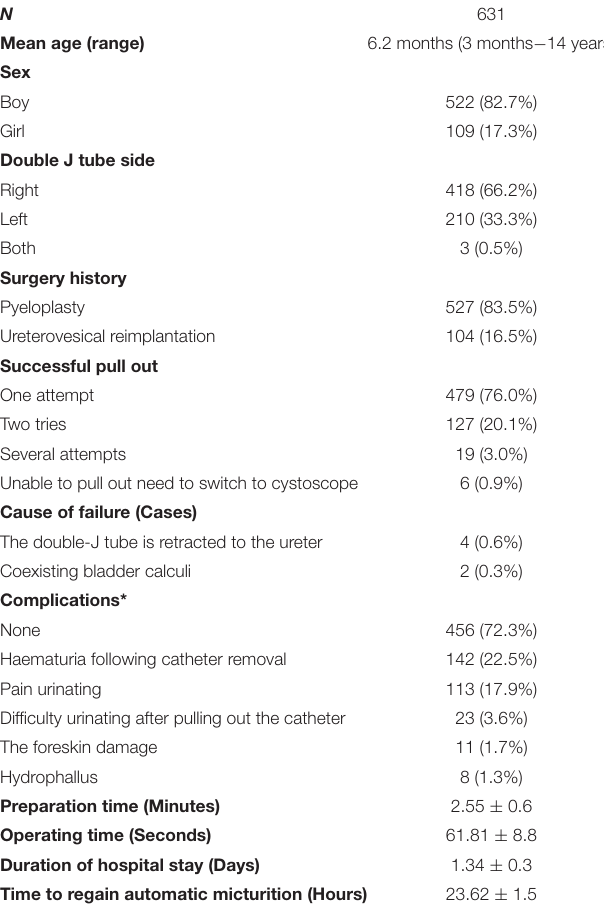
TABLE 1 | Patient demographics and related information of modified simple double J ureteral stent